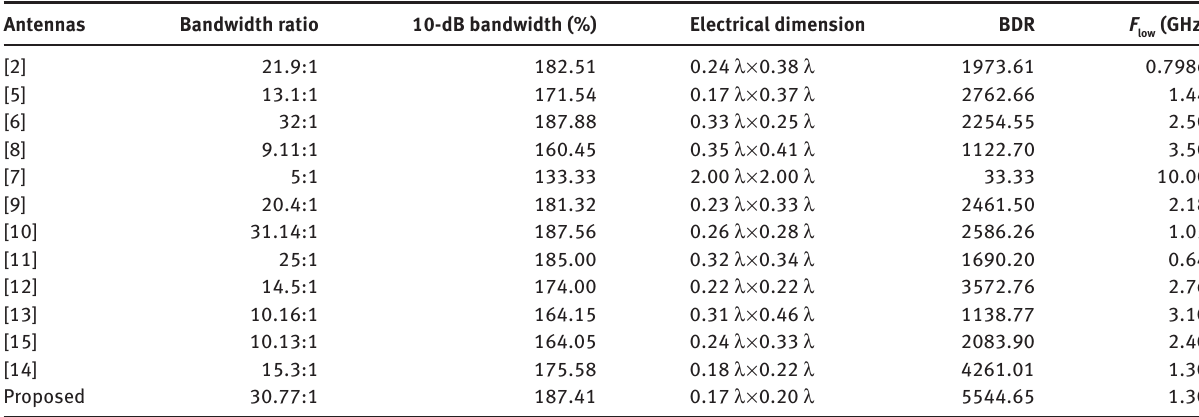
Table 1: BDR comparisons among existing antennas with other parameters.